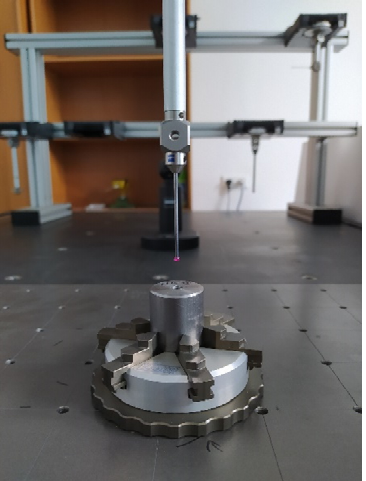
Table 3. Parameters of the ZEISS PRISMO Navigator coordinate measuring machine.